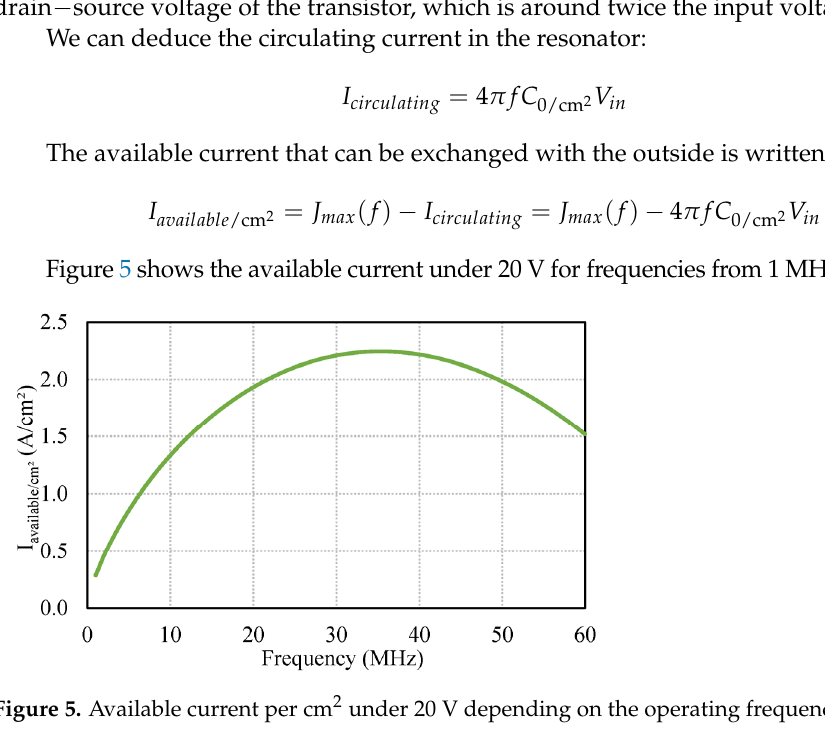
is determined by simulation, which gives a minimum useful current of I u_min